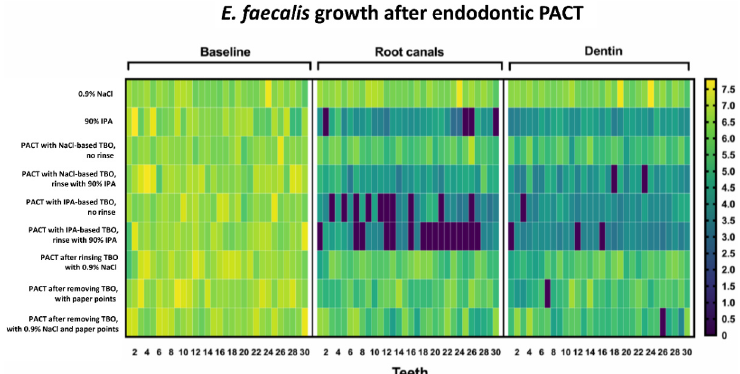
Figure 2. Heatmap showing the absolute distribution (in log 10 / mL) of E. faecalis after 72 h-incubation and subsequent PACT in root canals of extracted teeth ( n = 270). Samples taken prior to treatment served as baseline, while samples from root canals and dentin chips were collected after PACT treatment. A 16-µg/mL toluidine blue solution (TBO) served as the photosensitizer, activated by a 100-mW LED light source. The following treatment groups were tested: irrigation using 0.9% NaCl (negative control) or 90% isopropanol (IPA; positive control), conventional PACT with NaCl-based TBO and no final rinse (standard control), PACT with NaCl-based TBO and final rinse with 90% IPA, PACT with IPA-based TBO and no final rinse, PACT with IPA-based TBO and final rinse with 90% IPA, PACT with removal of access photosensitizer using either 0.9% NaCl solution or sterile paper points or both. Tooth numbers for each treatment group are shown in columns and treatment groups in rows. The colors as depicted on the color scale bars on the right vary to indicate data values change from very low to extremely high.